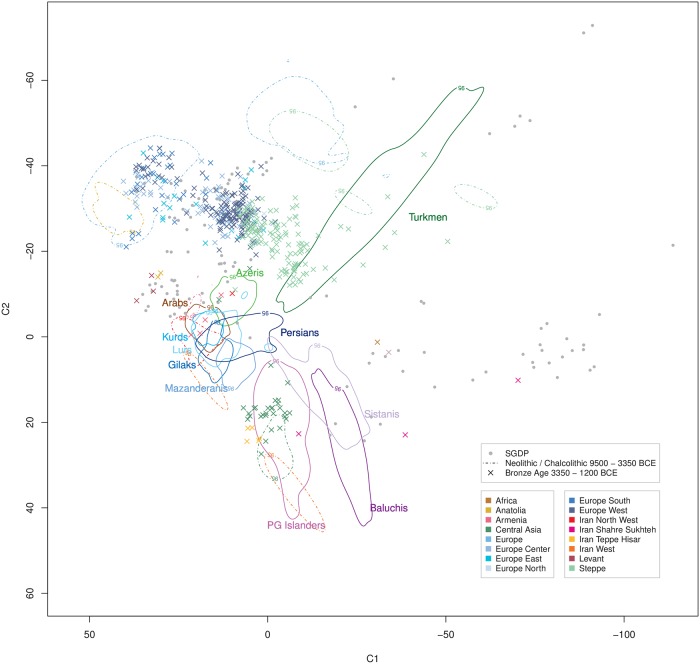
Ancient DNA samples from 3350–1200 BCE in the context of extant Iranian ethnic groups.Time-period specific ancient DNA samples (S3 Table) projected onto extant human variation (S18 Fig). The geographic origin of the ancient samples is coded by color. Previous time strata are indicated by 95% density limits (refer to Fig 5).